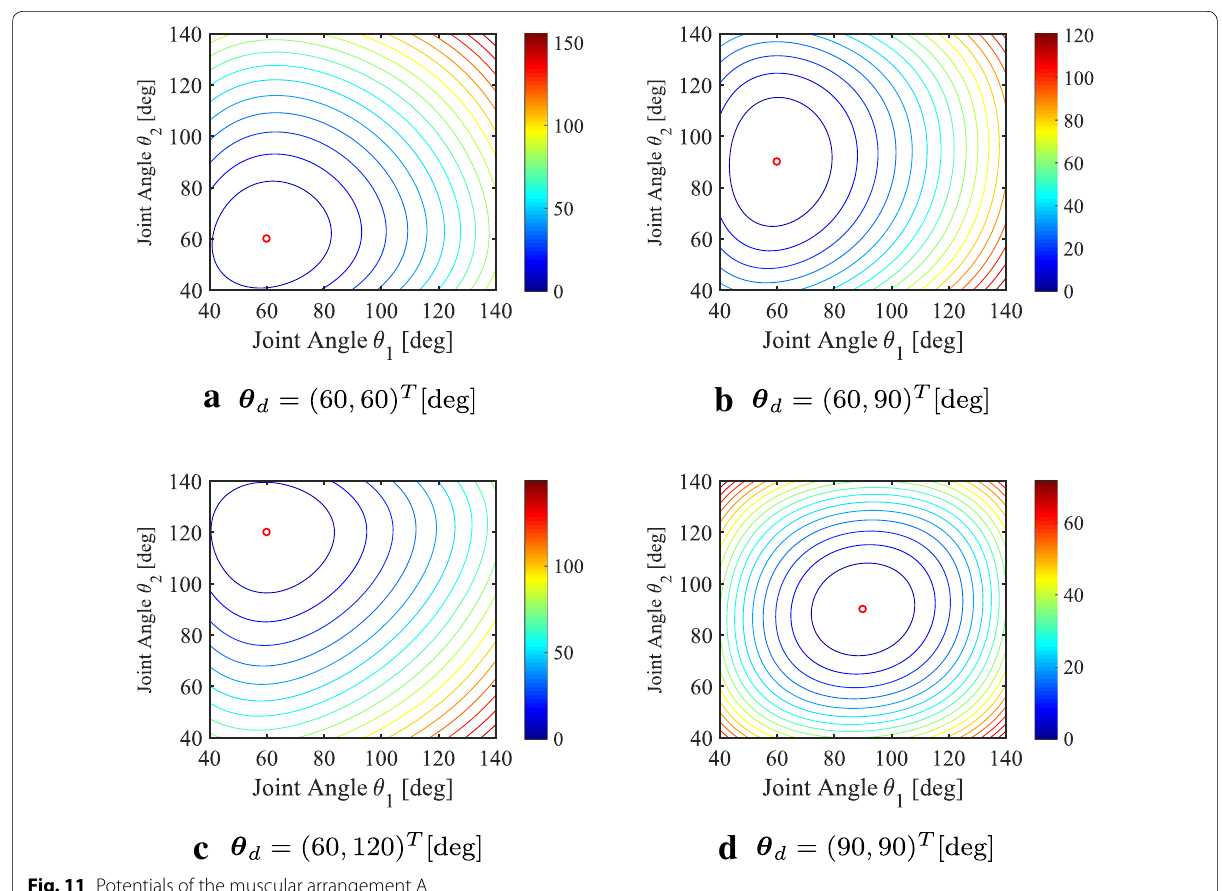
Fig. 11 Potentials of the muscular arrangement